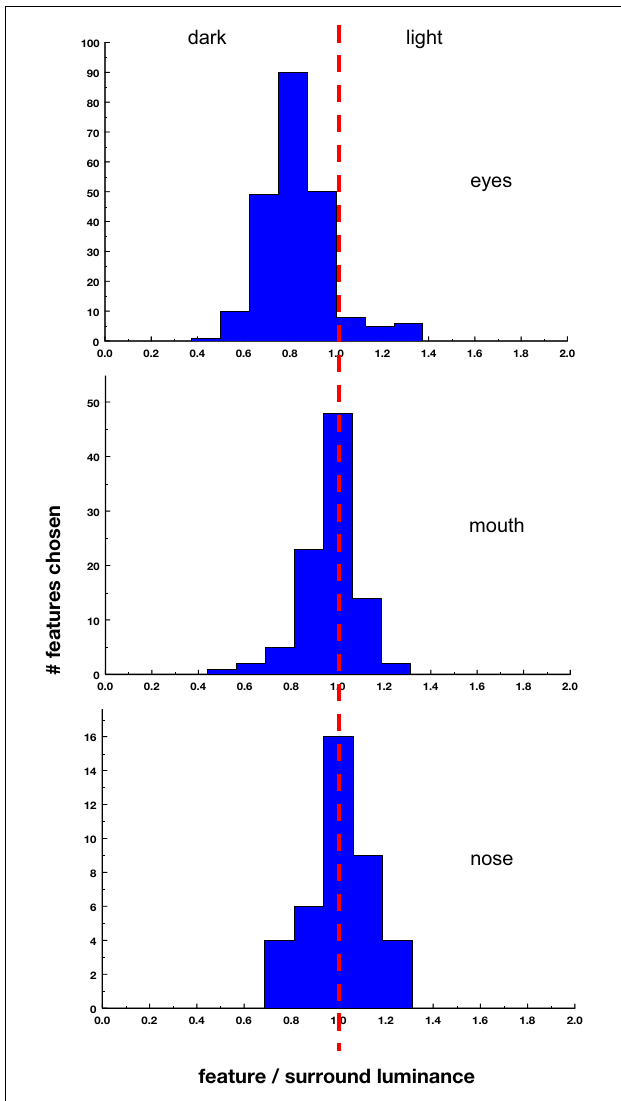
FIGURE 3 | Ratio of the average luminance (pixel gray level) of features relative to the average luminance of the surrounding annulus.